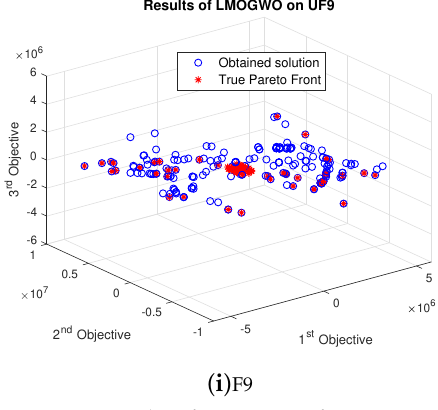
Figure 9. Results of LMOGWO for Scenario 2.